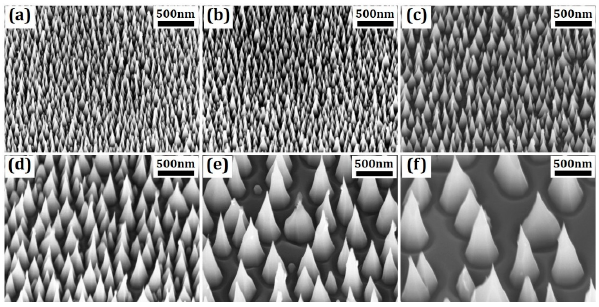
Figure 4. ( a – f ) SEM image of antireflective structures on SiC substrate fabricated from samples with deposited Au film thicknesses of 3 nm, 5 nm, 7 nm, 9 nm, 11 nm, and 13 nm, respectively.